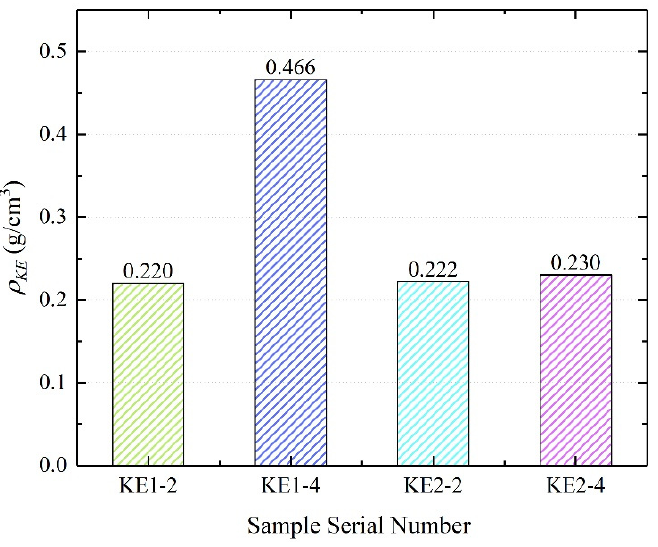
Figure 6. KE calculation result.